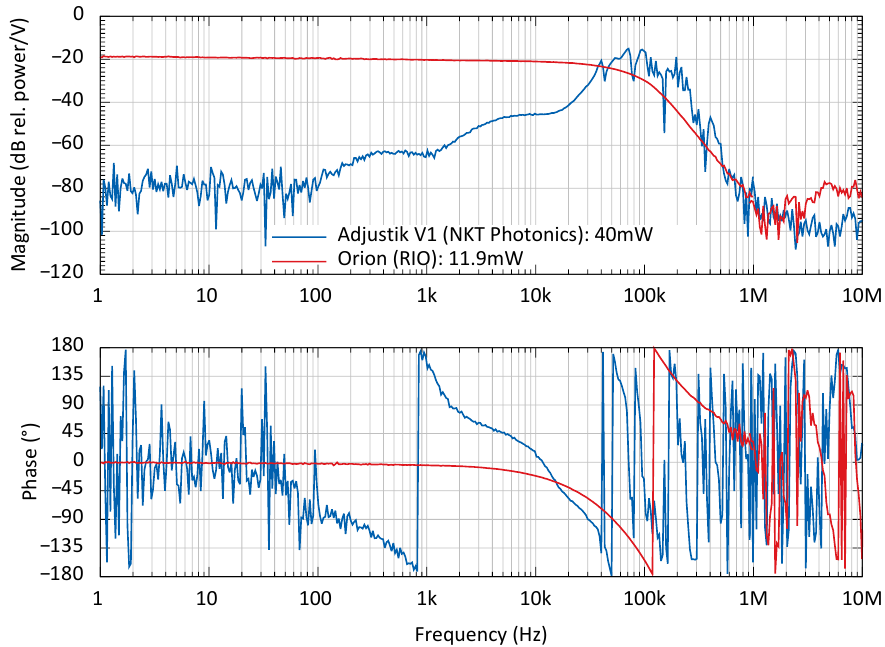
Figure 5. The cross-couplings from frequency actuation to the output power of the Orion laser and fiber laser is shown. As the pump current for the Orion laser also defines the output power, a direct coupling is observed. Meanwhile, the output power of the fiber laser shows a strong coupling only around